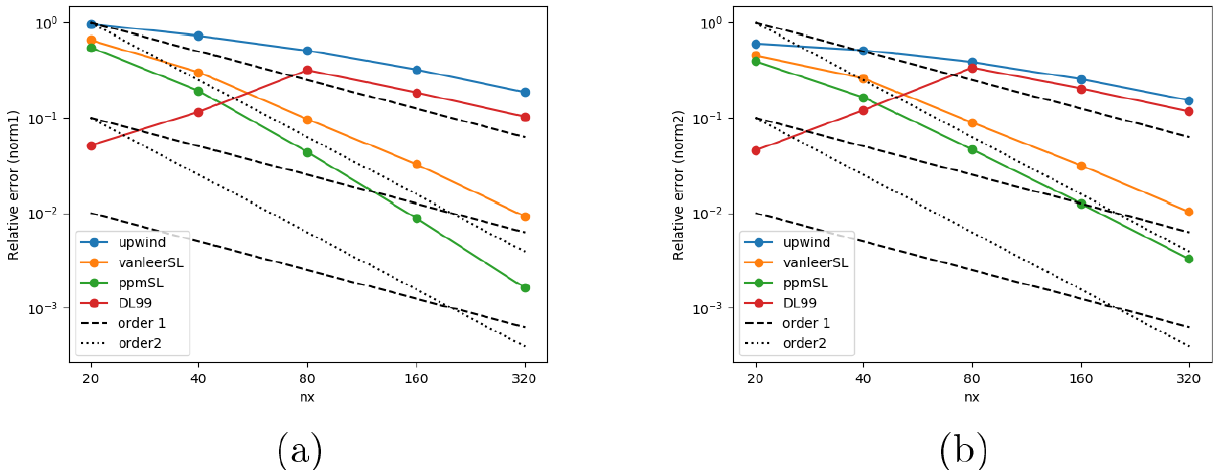
Figure 3. Convergence rate results for the four tested vertical advection schemes as a function of the number of horizontal points n x in the horizontal direction, in (cid:107)·(cid:107) 1 (a) and (cid:107)·(cid:107) 2 (b) for Case 3. The black dashed lines show the slope expected for order 1 (long dash) and order 2 (short